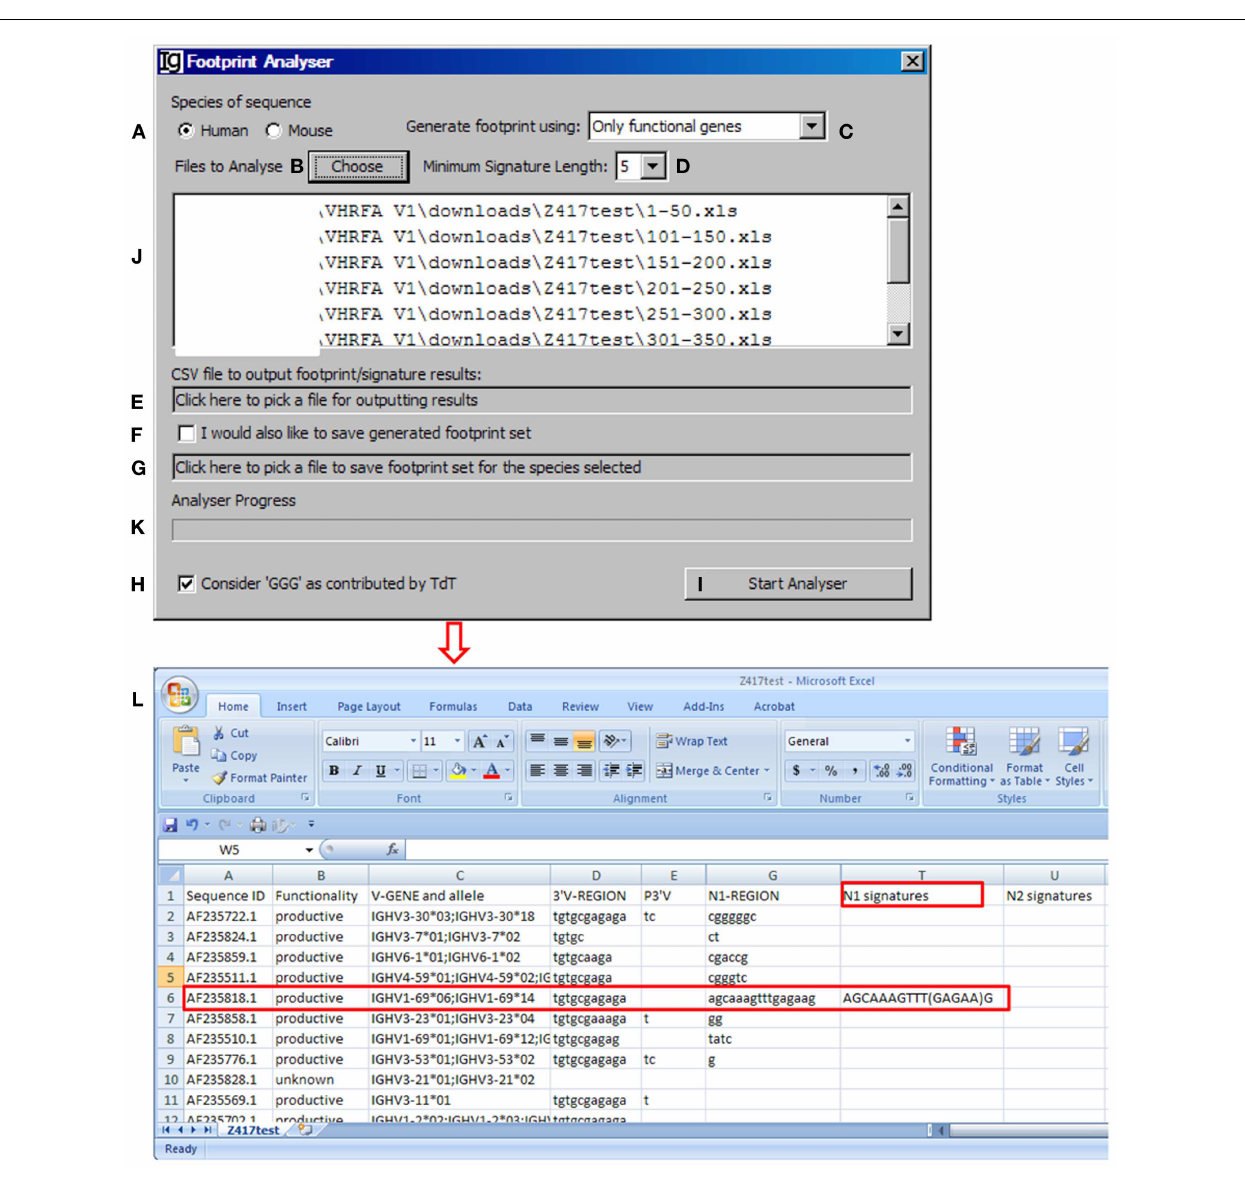
FIGURE 4 |The footprint analyzer . Diagram shows the interface of the Footprint Analyzer .The user can specify the species of the sequences (A) , choose input Excel files downloaded from IMGT/V-QUEST (B) , choose the source of footprints used to identify potentialV H replacement products (C) , set the criterion as to the minimum length of footprints (D) , choose the CSV file for storing footprint analysis result (E) , chose to store the used footprint file (F) , specify the name and location of the used footprint